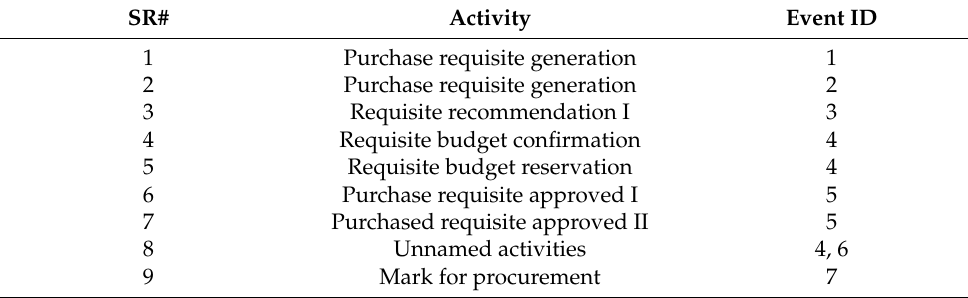
Table 2. Activities with their corresponding event IDs.